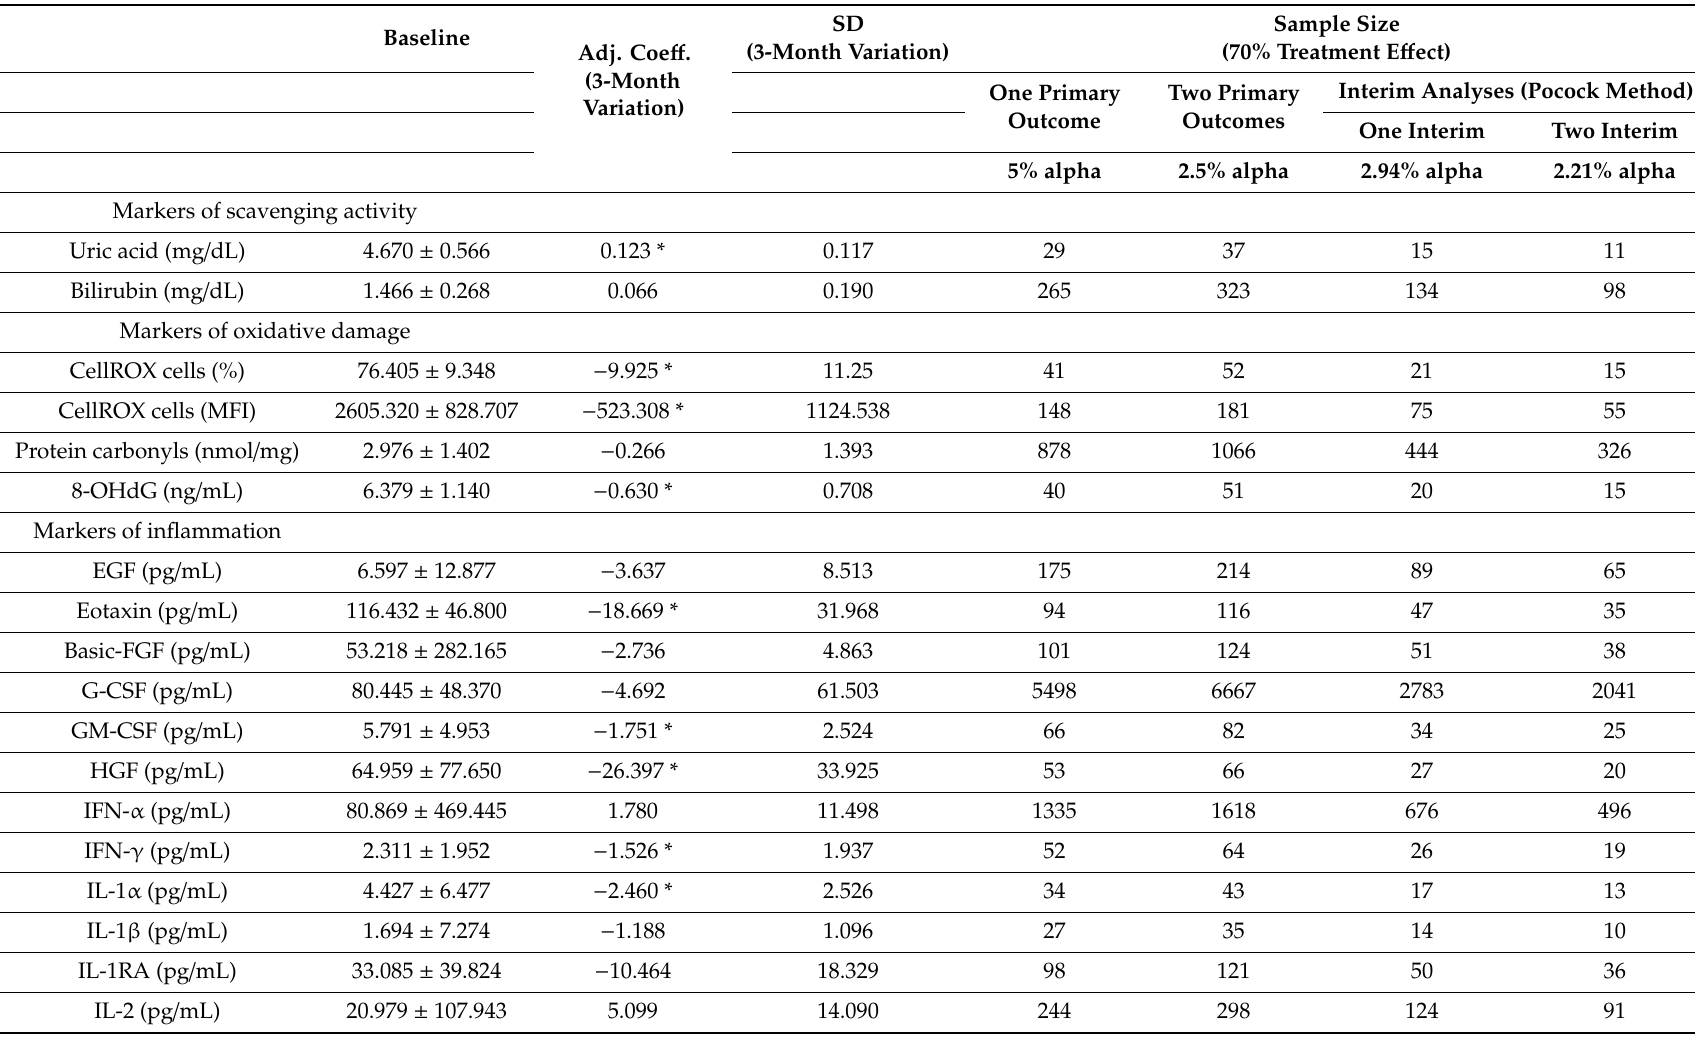
Table 1. Sample size estimates for a treatment arm for 3-month variations of peripheral biomarkers of oxidative stress and